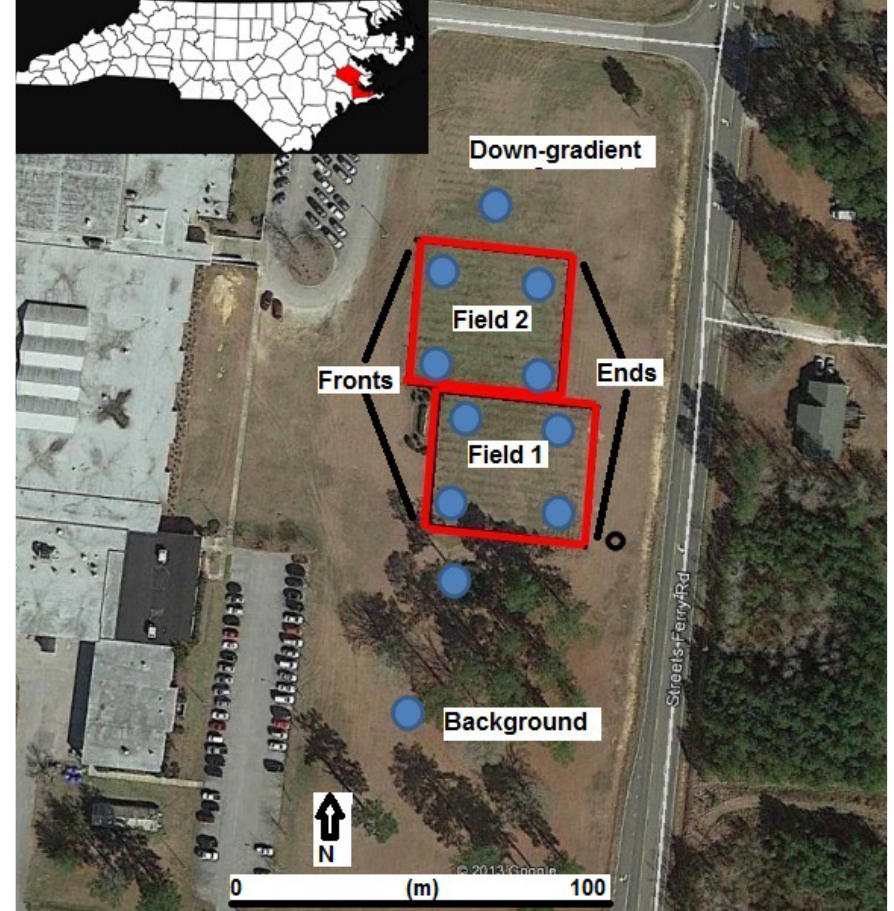
Figure 3. West Craven High School (WCH) in Craven County, North Carolina. The blue circles show the location of monitoring wells, the red boxes show drainfields 1 and 2. The fronts of the drainfields are located on west side of the boxes, while the ends of the drainfields are located on the east side of the boxes. Groundwater flow direction is to the